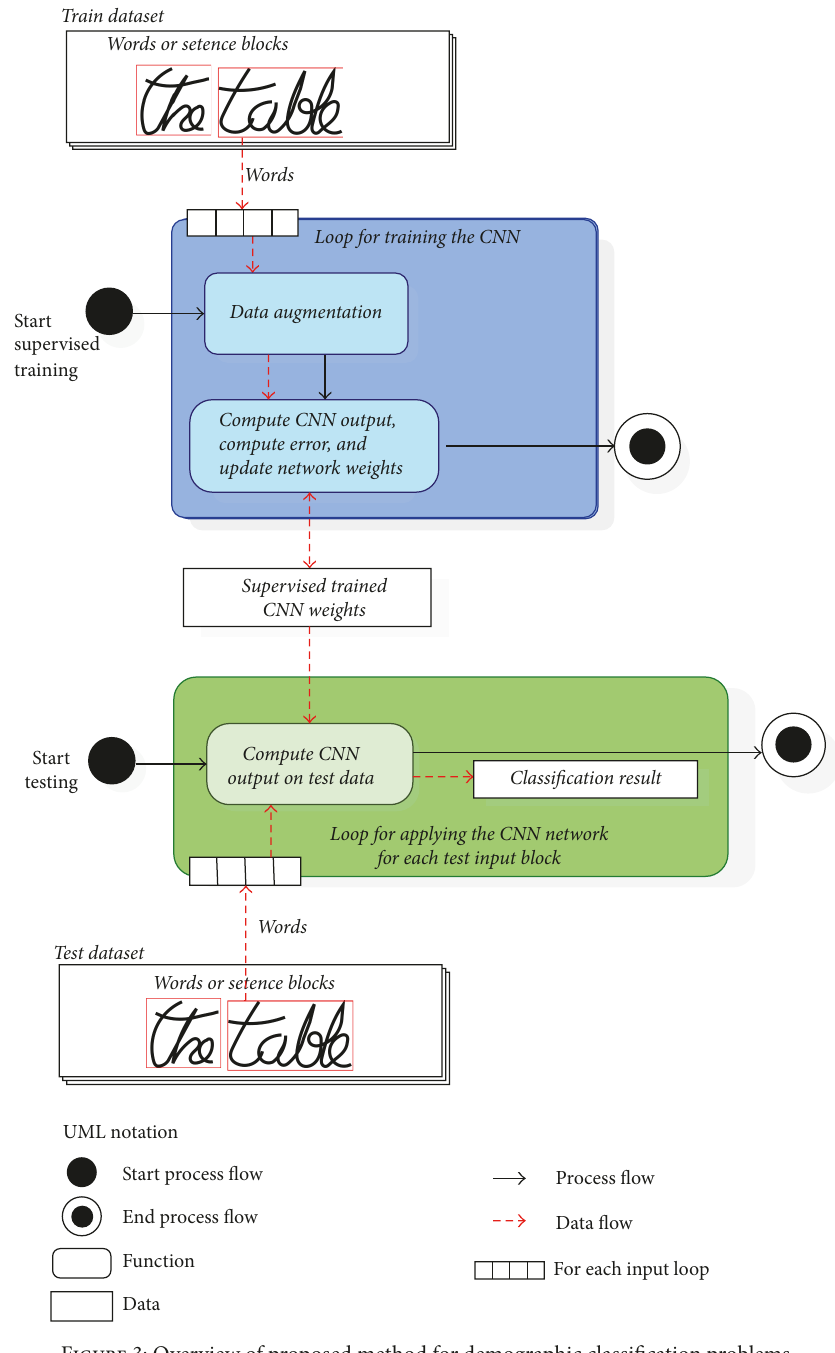
Figure 3: Overview of proposed method for demographic classification